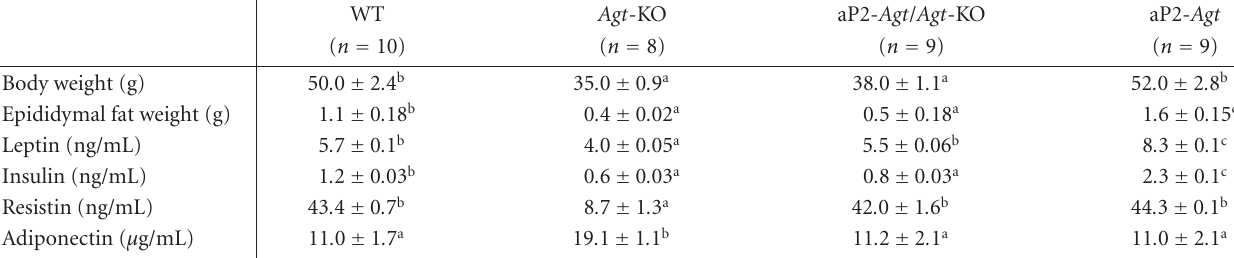
Table 1: Body weight, fat pad weight, and blood parameters in 28-wk-old WT, Agt -KO, aP2- Agt / Agt -KO, and aP2- Agt mice.